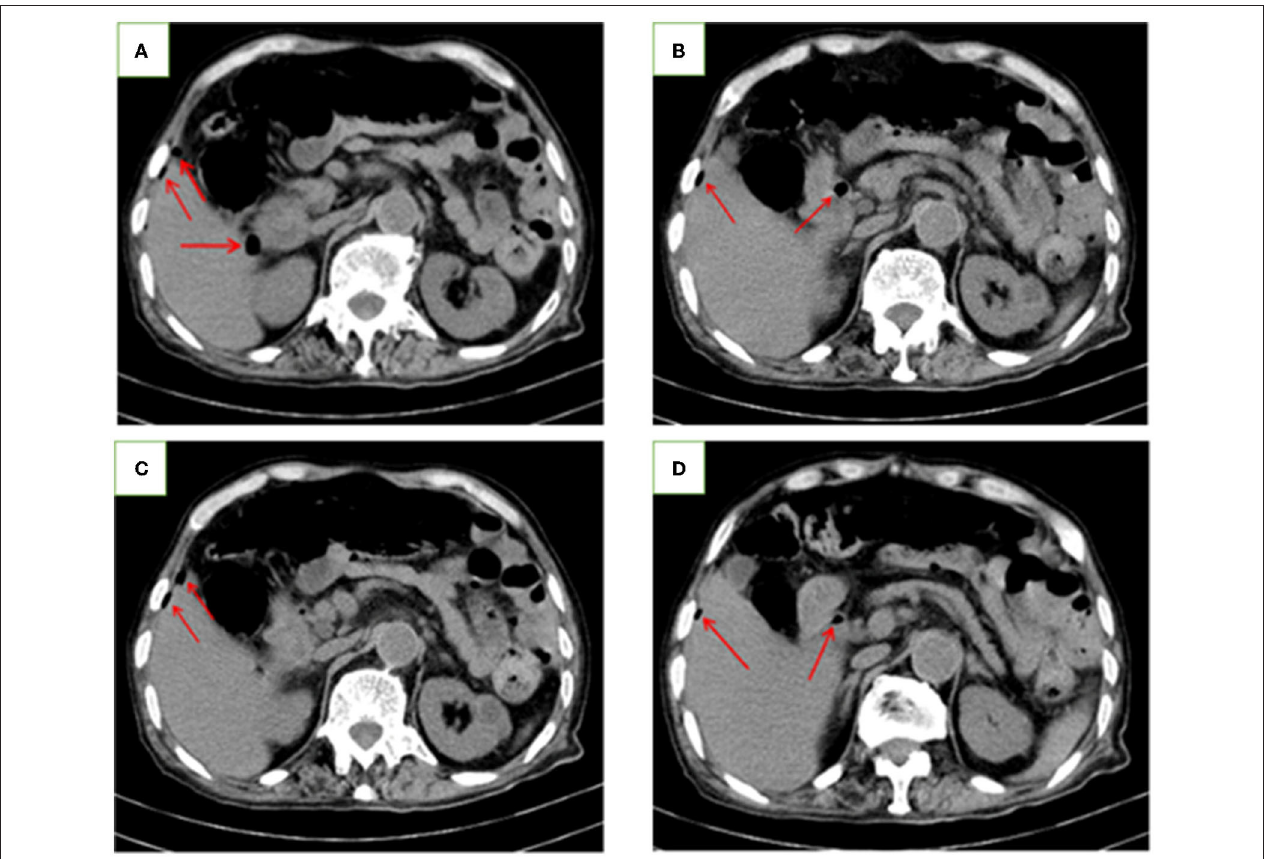
FIGURE 1 | Abdominal CT images of the patient. (A–D) Abdominal CT scan showing the free gas (red arrow) in the abdominal